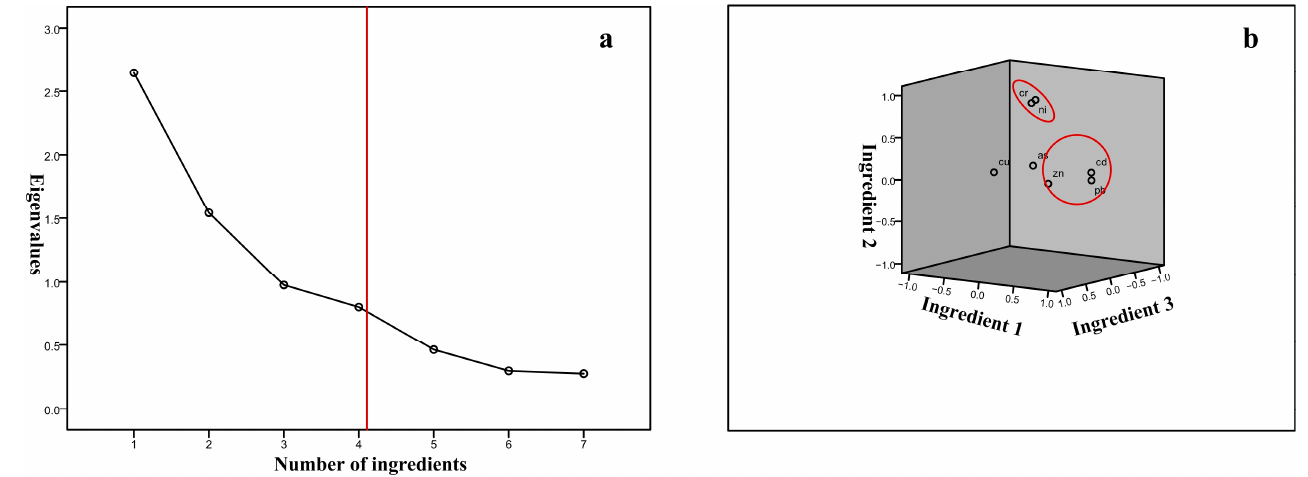
Figure 4. Gravel map of principal component analysis ( a ) and component map of rotating space ( b ).